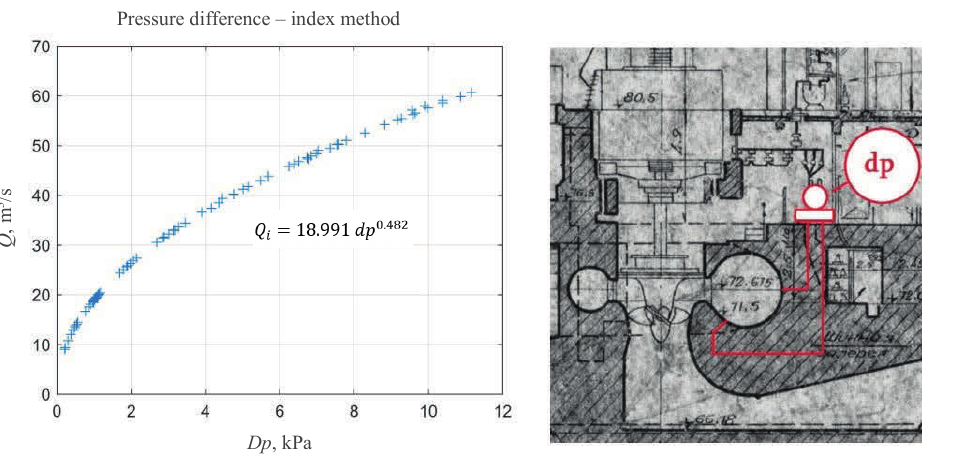
Fig. 3. Winter-Kennedy method scheme – flow